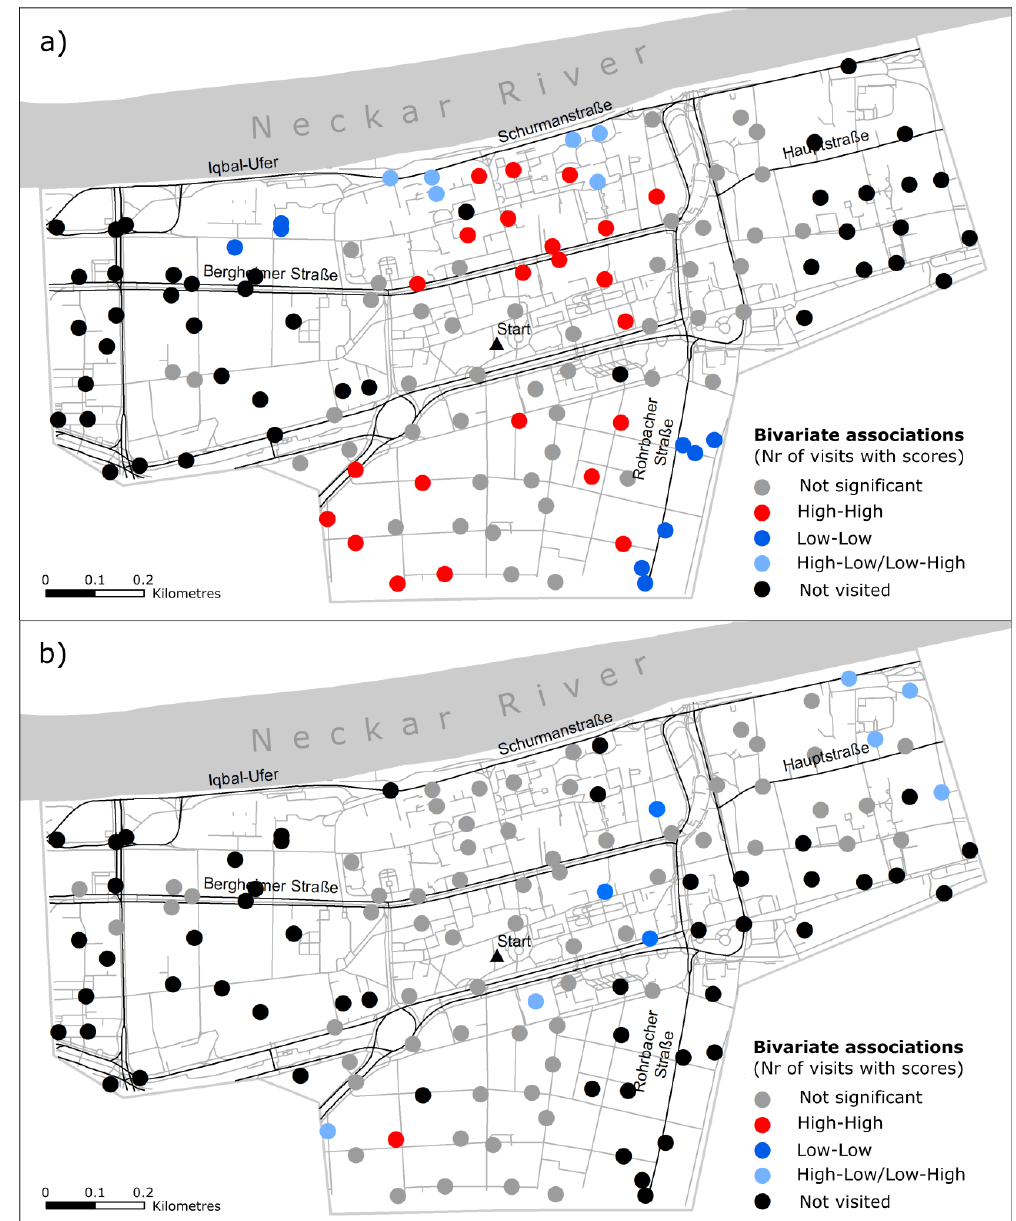
Figure 6. Bivariate spatial relationship between the numbers of visits of task locations and their surrounding scores. ( a ) Spatially structured setup; ( b ) and spatially random